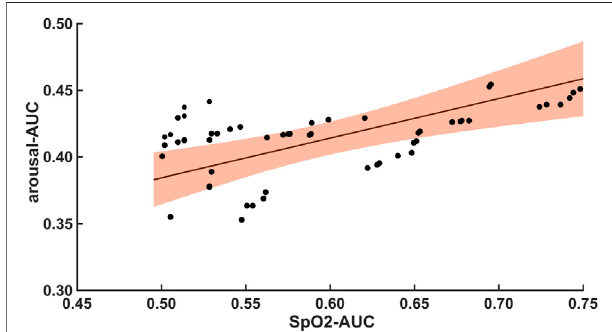
Frontiers in Physiology |